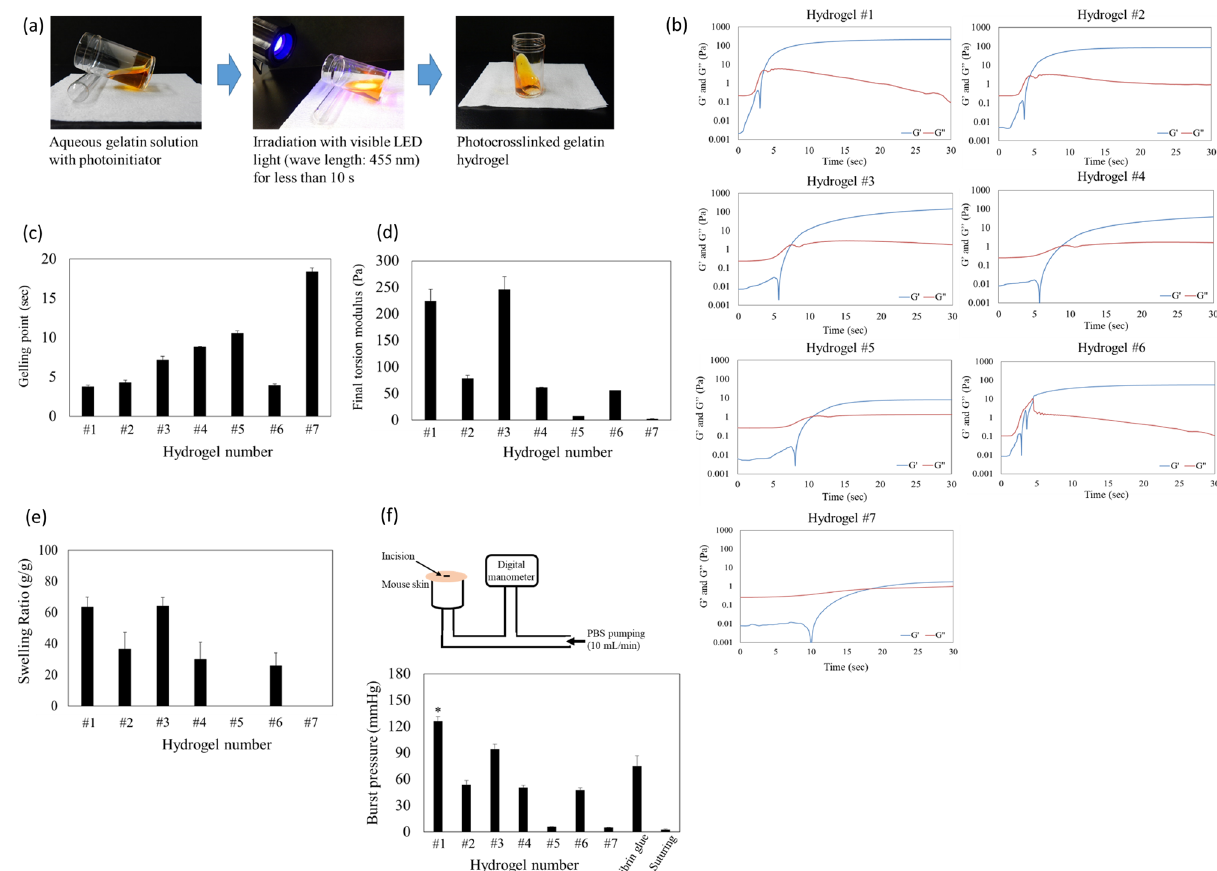
Figure 1. Formation and characterization of hydrogel crosslinked by light irradiation. ( a ) Process of hydrogel formation by photocrosslinking. ( b – e ) Mechanical properties of the photocrosslinked gelatin hydrogels. ( b ) To monitor the gelling process, a dynamic time-sweep rheological analysis was conducted using an in situ photo-rheometer (HAAKE Mars and LED 455 nm) showing the formation kinetics for photocrosslinked gelatin hydrogels. ( c ) Gelling points and ( d ) the final torsion moduli, G ′ , of different hydrogels. The exposure time for all gelling measurements was 120 s (error bars, mean ± SD; n = 3 per group). ( e ) Swelling ratios of different hydrogels ( n = 8 per group) after 24 h incubation in PBS at 37 °C (error bars, mean ± SD). ( f ) Burst pressure